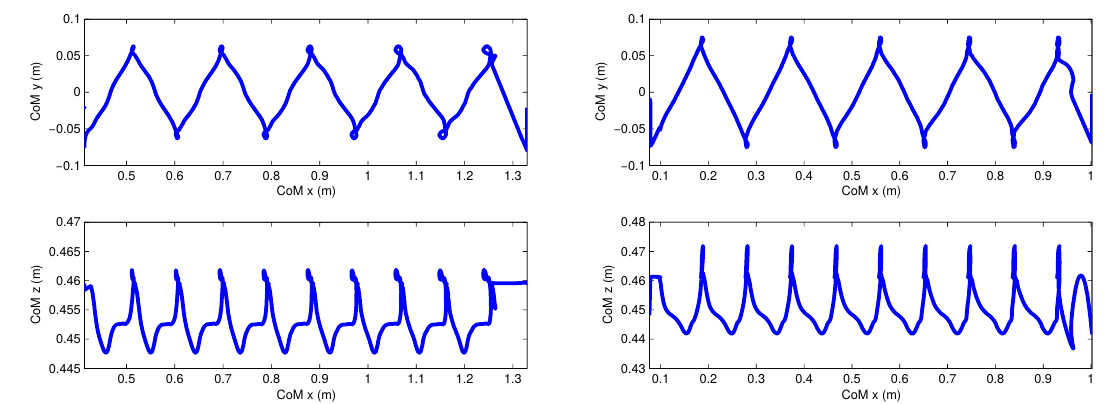
Figure 7. Center of mass trajectories of a full sequence with nine periodic steps combinations of objectives as in Table 2.